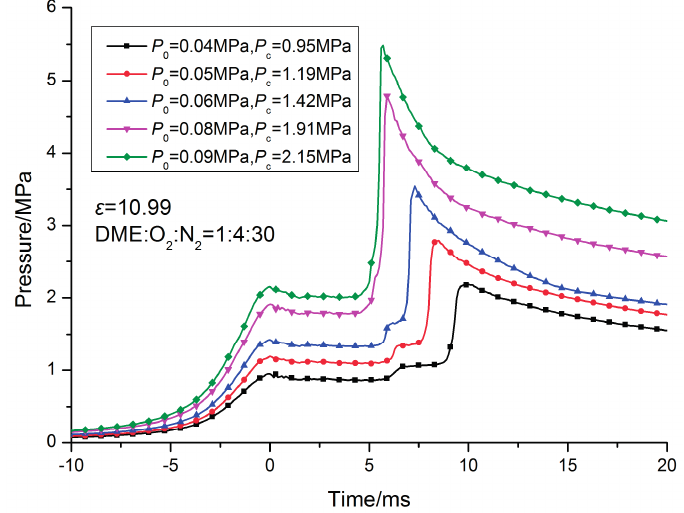
Figure 18. Effect of initial pressure on two-stage ignition delay ( ε =